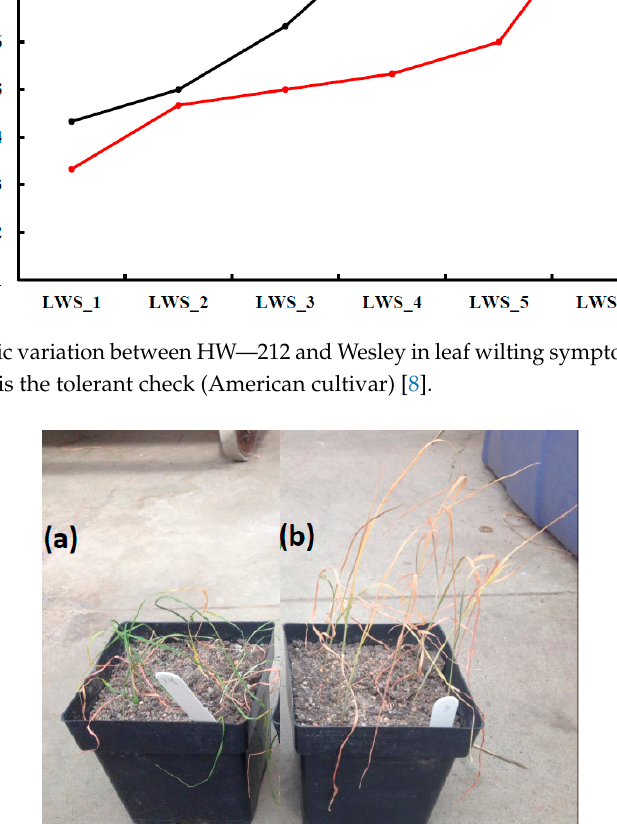
Figure 4. Responses of genotypes to drought stress. ( a ) a genotype had a little regrowth after rewatering and the leaves if un-cutting plants were not recovered, ( b ) a genotype did regrew after